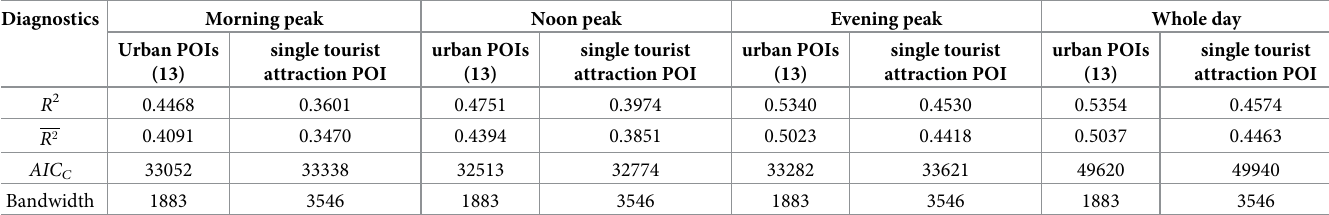
Table 7. Comparison results of the GWR model between urban POIs (13) and single tourist attraction POI on weekends. Diagnostics Morning